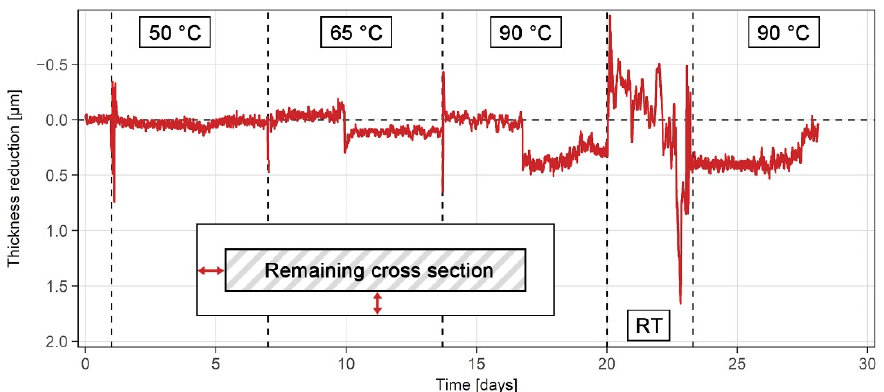
Figure 9. ER thickness reduction results for the grade 2507 steel during 28 days of exposure to a 10% H 2 SO 4 solution with 5000 mg/L NaCl at various temperatures.